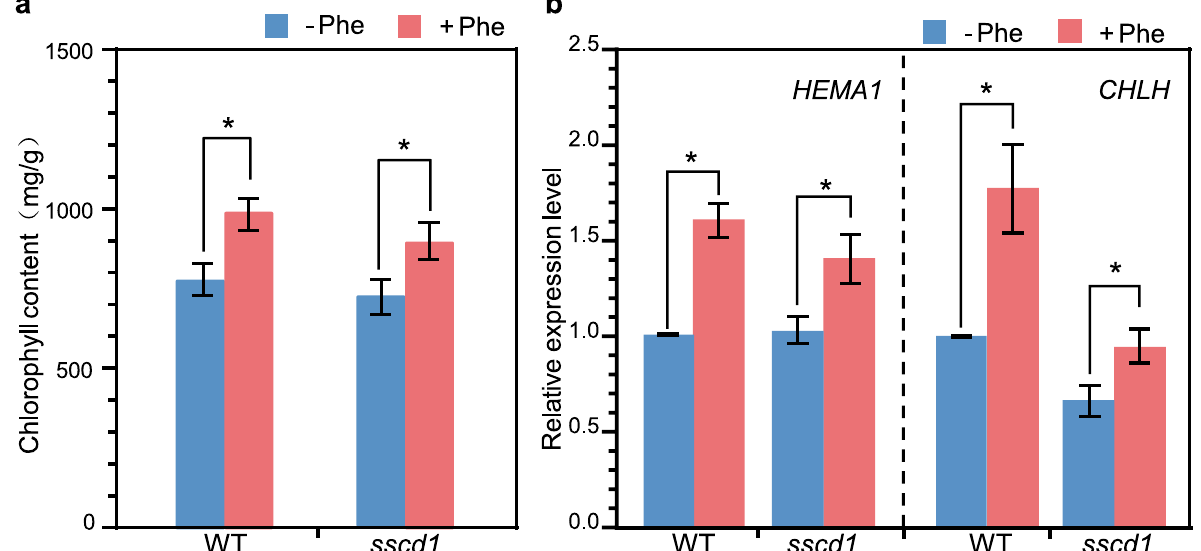
Figure 3. Chlorophyll synthesis was increased after Phe treatment. ( a ) The content of chlorophyll in WT and sscd1 seedlings which were first grown in MS medium under LD for 7 days and transplanted to MS medium added without (−) or with (+) 2 mM Phe under LD for an additional 7-day growth, and then transferred to SD for a 3-day growth. ( b ) The relative expression levels of CHLH and HEMA1 in WT and sscd1 seedlings which were first grown in MS medium under LD for 7 days and transplanted to MS medium added without (−) or with (+) 2 mM Phe under LD for additional 7-d growth, and then transferred to SD for a 3-d growth. ACTIN2 expression was used as the internal control. Each value is the mean of three independent biological replicates ± standard deviation. An asterisk represents the significance of differences (two-tailed Student’s t-test) at the levels of P < 0.05. WT wild type, Col-0; LD long day; Phe phenylalanine; SD short